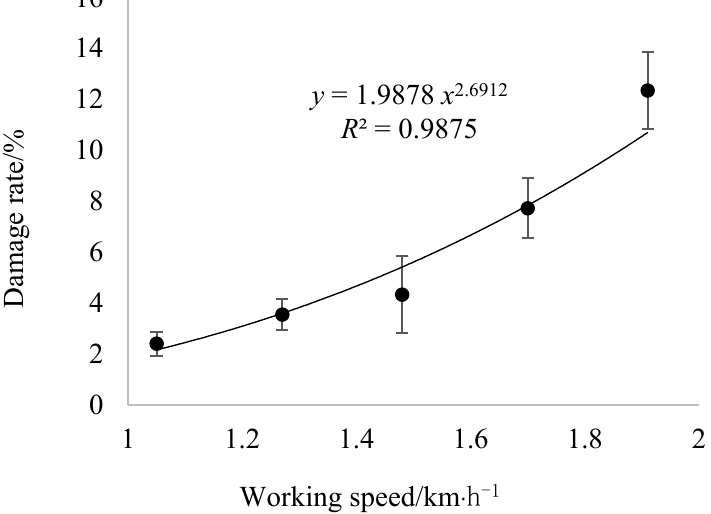
Figure 8. Effect of equivalent friction on damage rate on working speed. Note: digging depth was 90 mm, lifting speed was 0.81 m · s − 1 and cutting height was 70 mm.